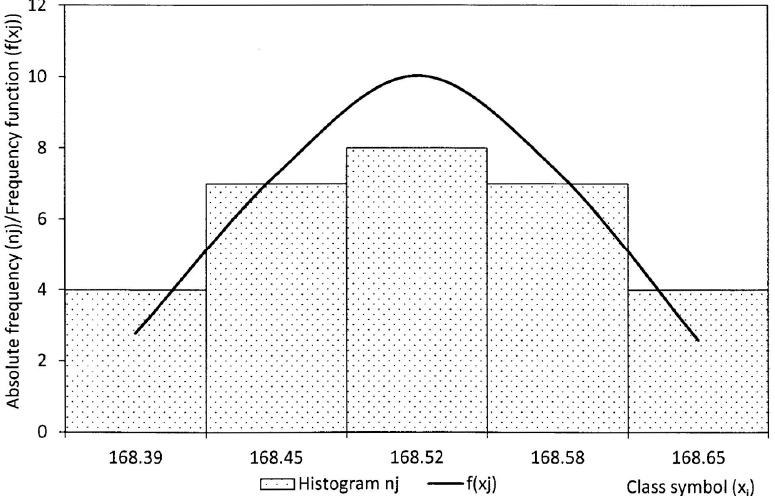
Figure 11. Histogram and frequency function for the width parameter, third day. From the Shewhart control chart (Figure 12) it can be determined that the process is stable even if it contains a series of five values in a row below the target value, which is not suitable. The use of the upper control limit except for the first value is very good.